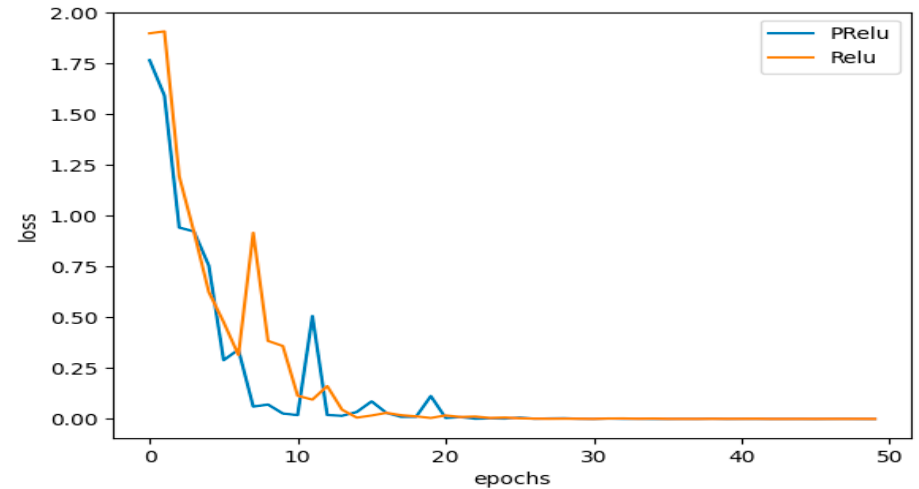
Figure 16. Variation in loss with iteration number under different activation functions.